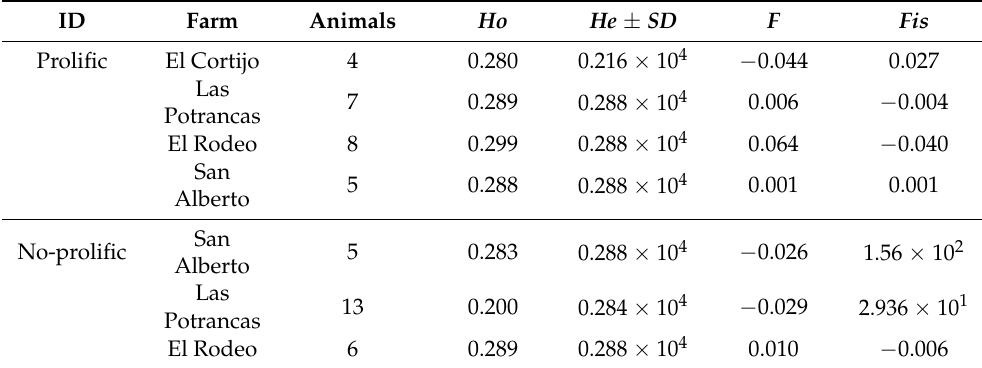
Figure 2. Identification of genomic characteristics. ( a ) Decay of the distance of markers in ligament disequilibrium (LD), as a function of the distance between markers in the entire Pelibuey sheep genome. ( b ) Distribution of the l LD block length for case-control. Table 2. Expected and observed heterozygosity ( He and Ho ), inbreeding coefficient ( F ), and inbreeding coefficient of an individual in subpopulation ( Fis ).